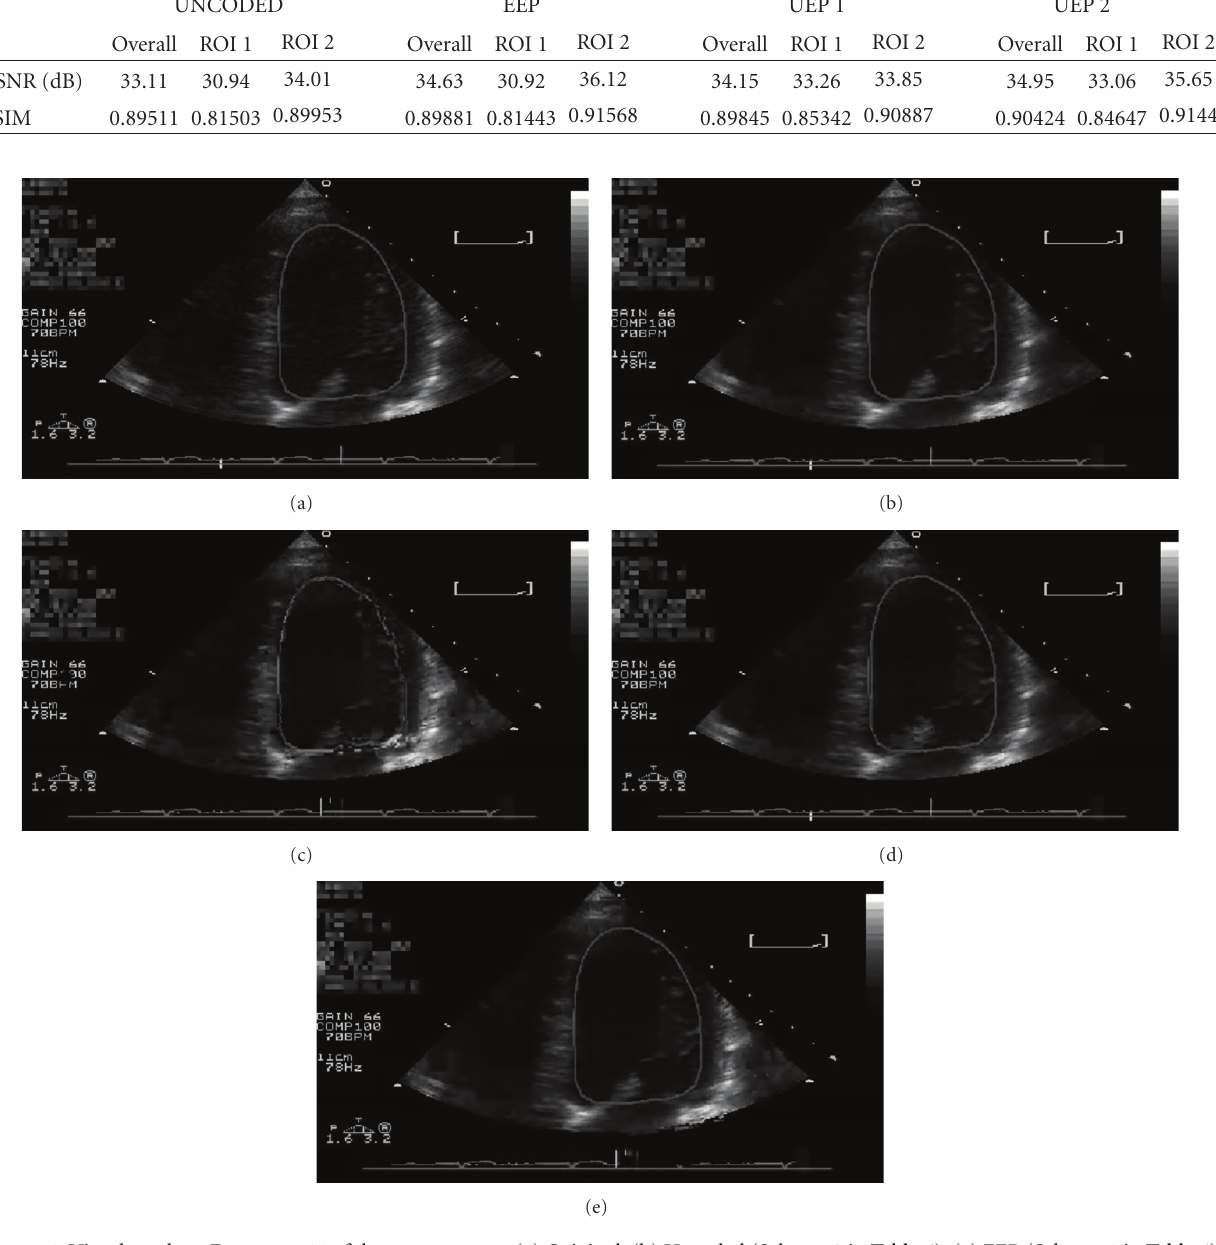
Figure 4: Visual results—Frame no. 44 of the test sequence. (a) Original; (b) Uncoded (Scheme 2 in Table 6); (c) EEP (Scheme 1 in Table 6); (d) UEP 1 (Scheme 3 in Table 6); (e) UEP 2 (Scheme 4 in Table